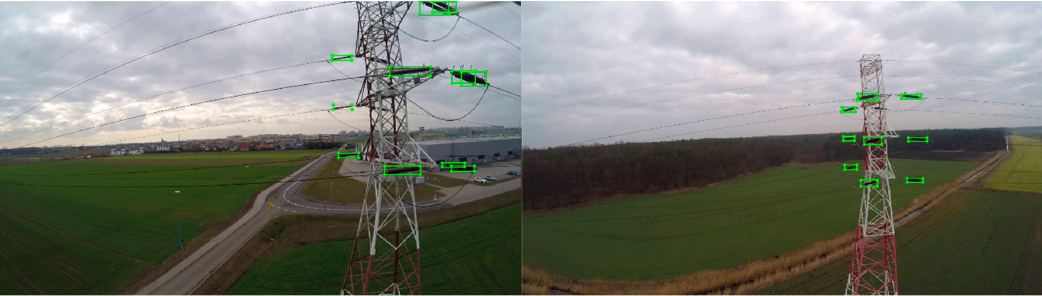
Figure 2. Examples of tagged images recorded during the flight of an unmanned aerial vehicle (UAV) along the high-voltage line.